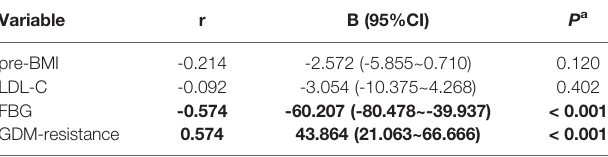
TABLE 3 | Multiple linear regression analysis between the clinical indicators and circulating FGF21 at delivery. Variable